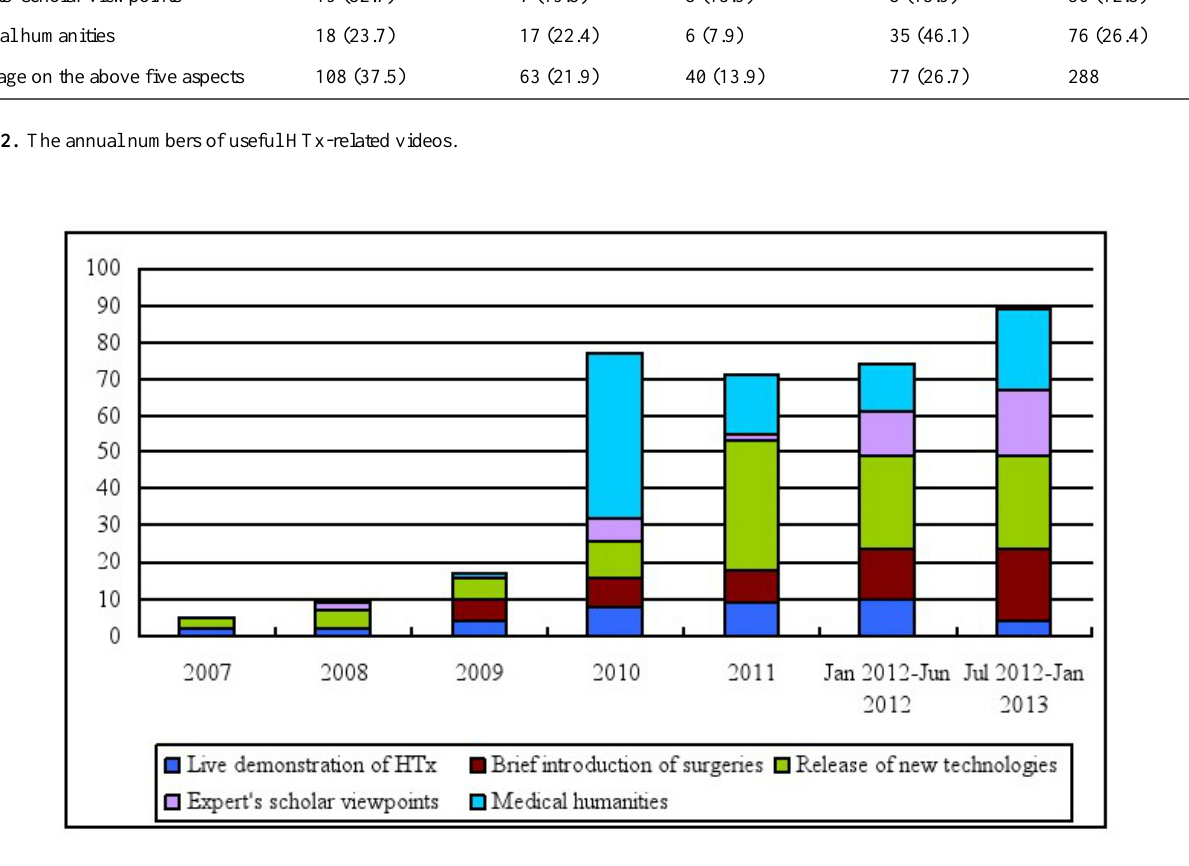
Total, n (%)News agency